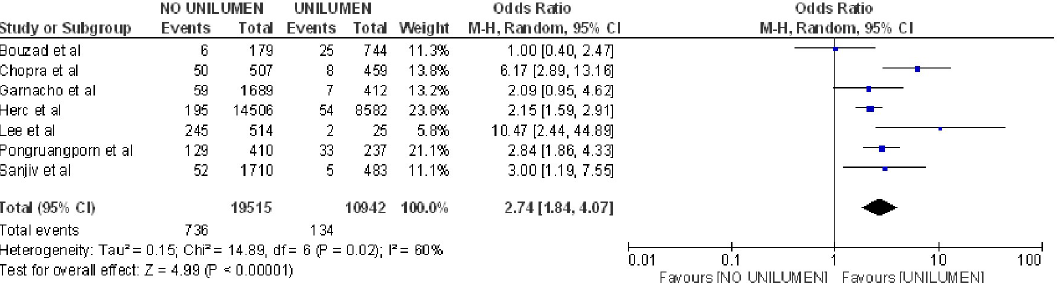
Fig 5. Forest Plot of unilumen catheter and CLABSI.